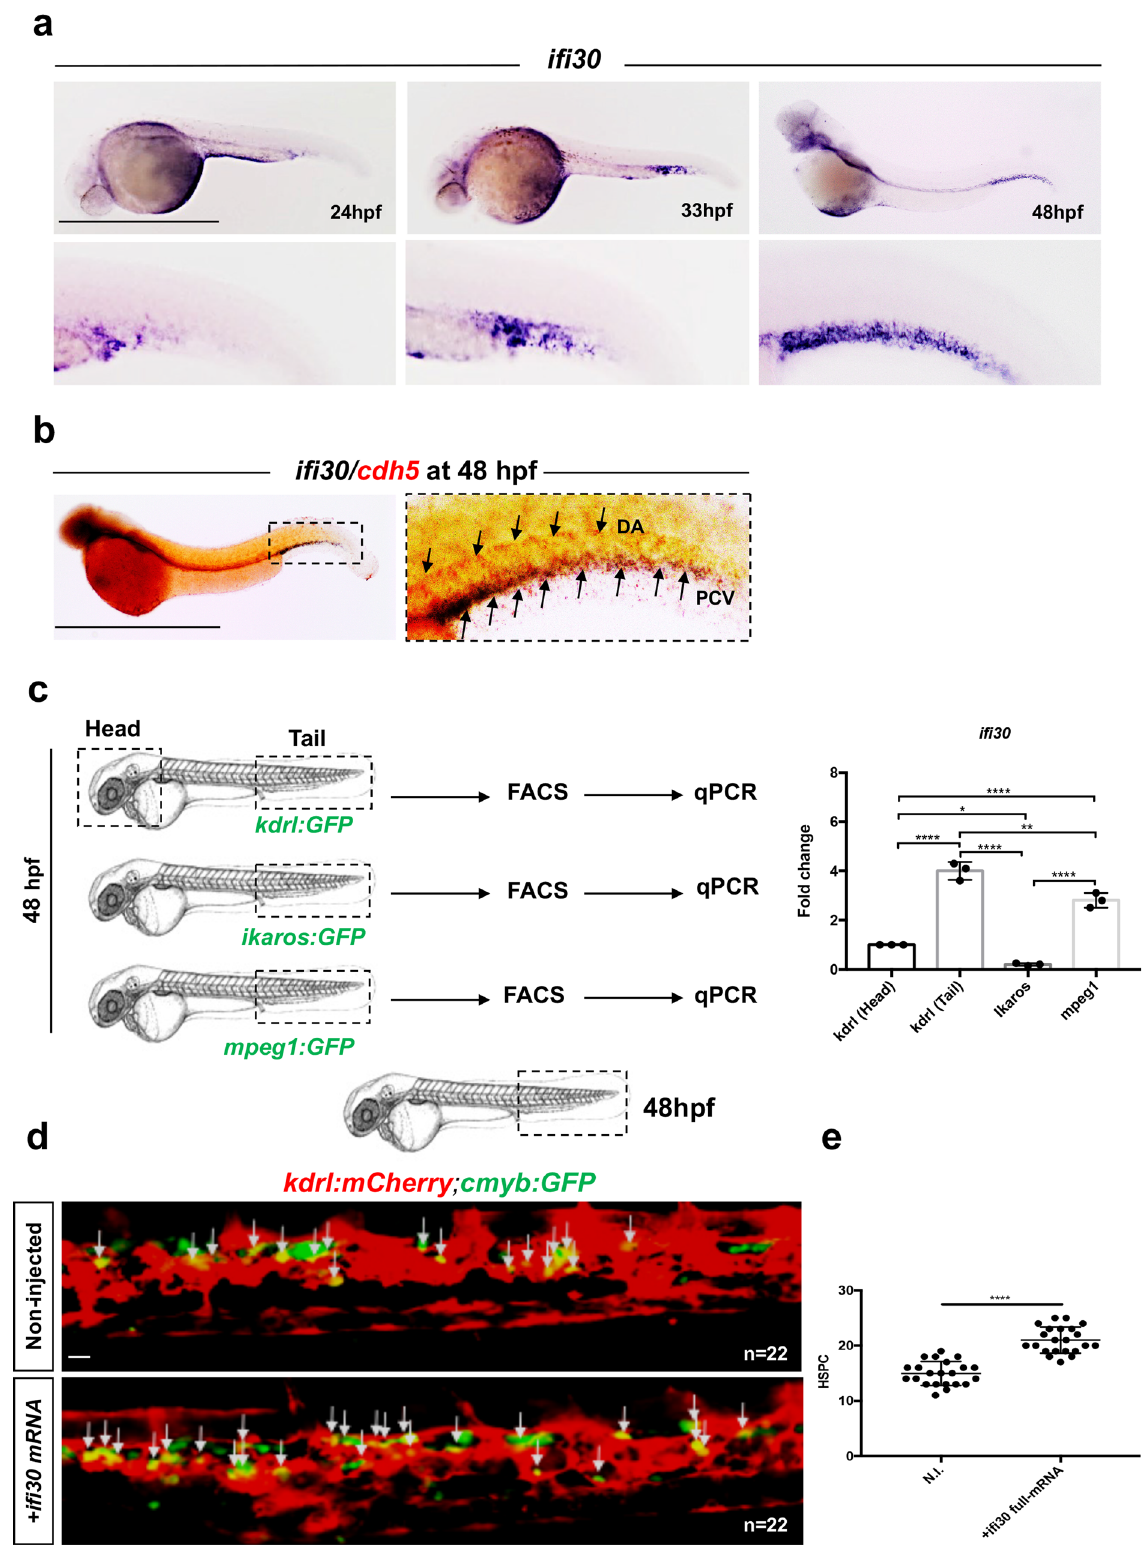
increase of rag1 expression at 4.5dpf in injected embryos (Sup- plementary Fig. 4a – c). However, this gain-of-function did not increase runx1 expression at 28hpf, therefore excluding any contribution of i fi 30 to HSPCs emergence (Supplementary Fig. 4d). Similarly, we observed no change in the number of HSPCs at 36hpf when i fi 30 full-length mRNA was injected